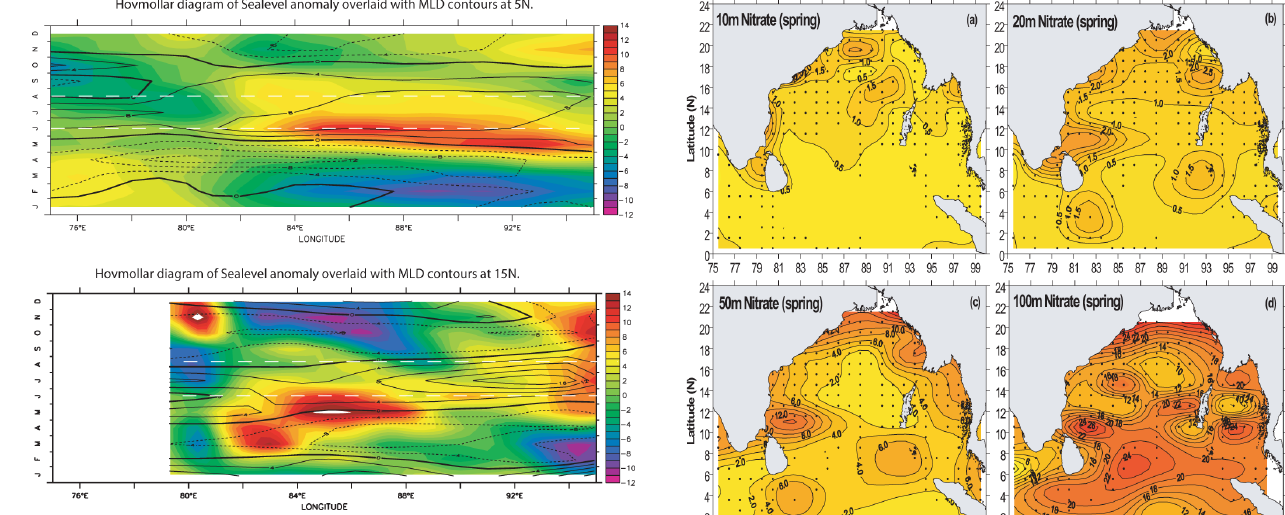
Figure 9. Time–longitude plots of monthly mean sea-level anomaly climatology (1992–2006) derived from merged sea-level anomalies of Topex/Poseidon and ERS 1/2 satellites overlaid with the mixed layer depth anomaly along 5 ◦ N (top panel) and 15 ◦ N (bottom panel) latitudes.